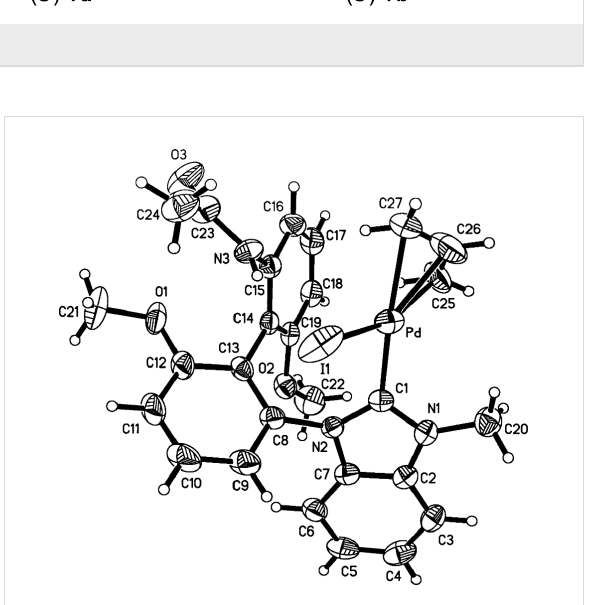
Figure 3: ORTEP drawing of NHC–Pd(II) complex ( S )- 7a with thermal ellipsoids at the 30% probability level. Selected bond distances (Å) and angles (deg): Pd–C1 = 2.050(5), Pd–C25 = 2.154(7), Pd–C26 = 2.128(9), Pd–C27 = 2.168(8), Pd–I1 = 2.6404(7), N1–C1–Pd = 125.6(4), N2–C1–Pd = 128.8(4), C1–Pd–I1 = 99.52(13), C1–Pd–C25 = 98.3(3), C1–Pd–C26 = 132.3(5), C1–Pd–C27 = 163.7(4), I1–Pd–C25